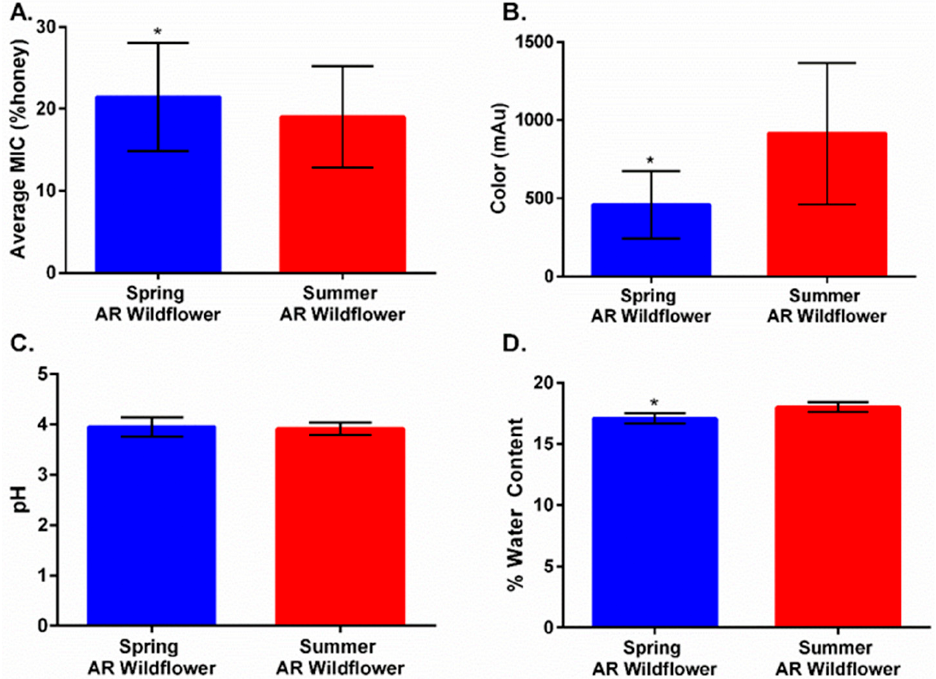
Figure 6. Comparison of average MIC, color, pH, and water content between spring and summer Arkansas wildflower (mean ± SD). ( A ) Average MIC across all bacterial species ( n = 7) varied significantly between spring ( n = 91) and summer honeys ( n = 56). Spring honeys had a significantly higher average MIC when compared to summer honeys (Mann–Whitney, p = 0.0225, U = 1987). ( B ) Comparisons of color yielded a significant difference between the two Arkansas wildflower honey harvests (unpaired t -test, p = 0.0167). Spring honeys ( n = 9) had a significantly lighter color compared to summer honeys ( n = 8). ( C ) No significant difference between spring honeys ( n = 13) and summer honeys ( n = 5) was observed when pH was evaluated (unpaired t -test, p = 0.7212). ( D ) When comparing water content, there was a significant difference between spring and summer (unpaired t -test, p = 0.0302). Spring honeys ( n = 2) were significantly lower in water content compared to summer honeys ( n = 6). * indicates significant difference.